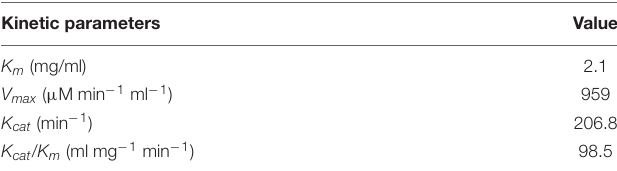
TABLE 1 | The kinetic parameters of Sh Csn46. Kinetic parameters